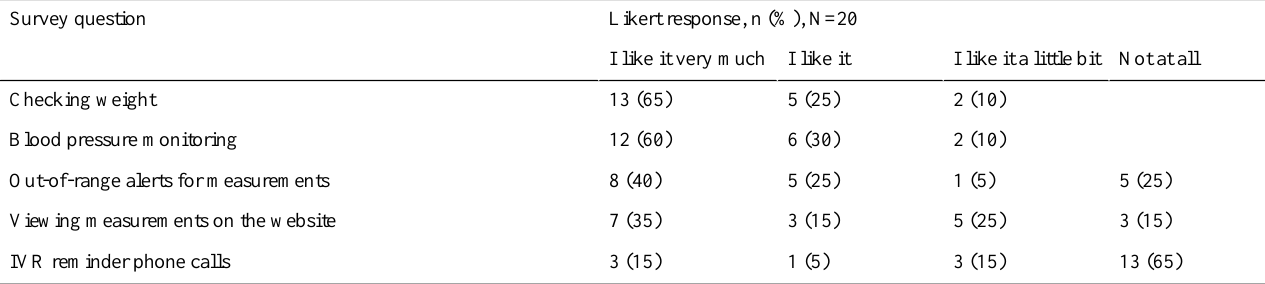
Table 6. Participants’(N=20) ratings of statements regarding use of the intervention components.